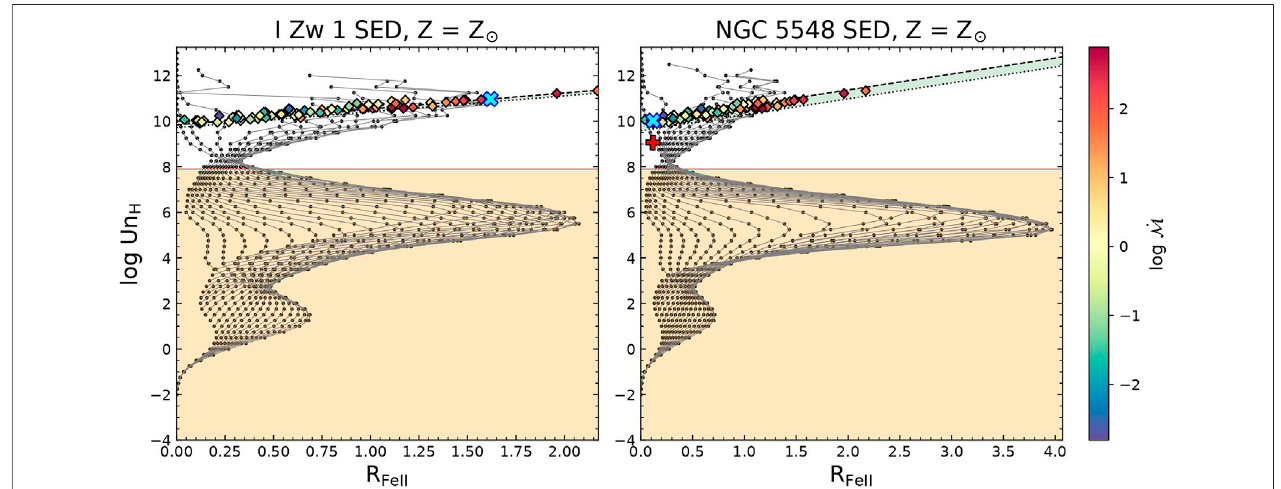
FIGURE8| log U − log n H 2Dhistogramscolor-weightedby(toppanels)equivalentwidths(EWs)FeII(middlepanels)EW(H β )and(bottompanels)R FeII .Thelabels and parameters shown here are identical to Figure 2 . The panels depict the models considered for a BLR metallicity of 3Z ⊙ (left panels), then for a metallicity of 3Z ⊙ with additional microturbulence of 20 km s − 1 (middle panels), and for a metallicity of 10Z ⊙ (right panels).